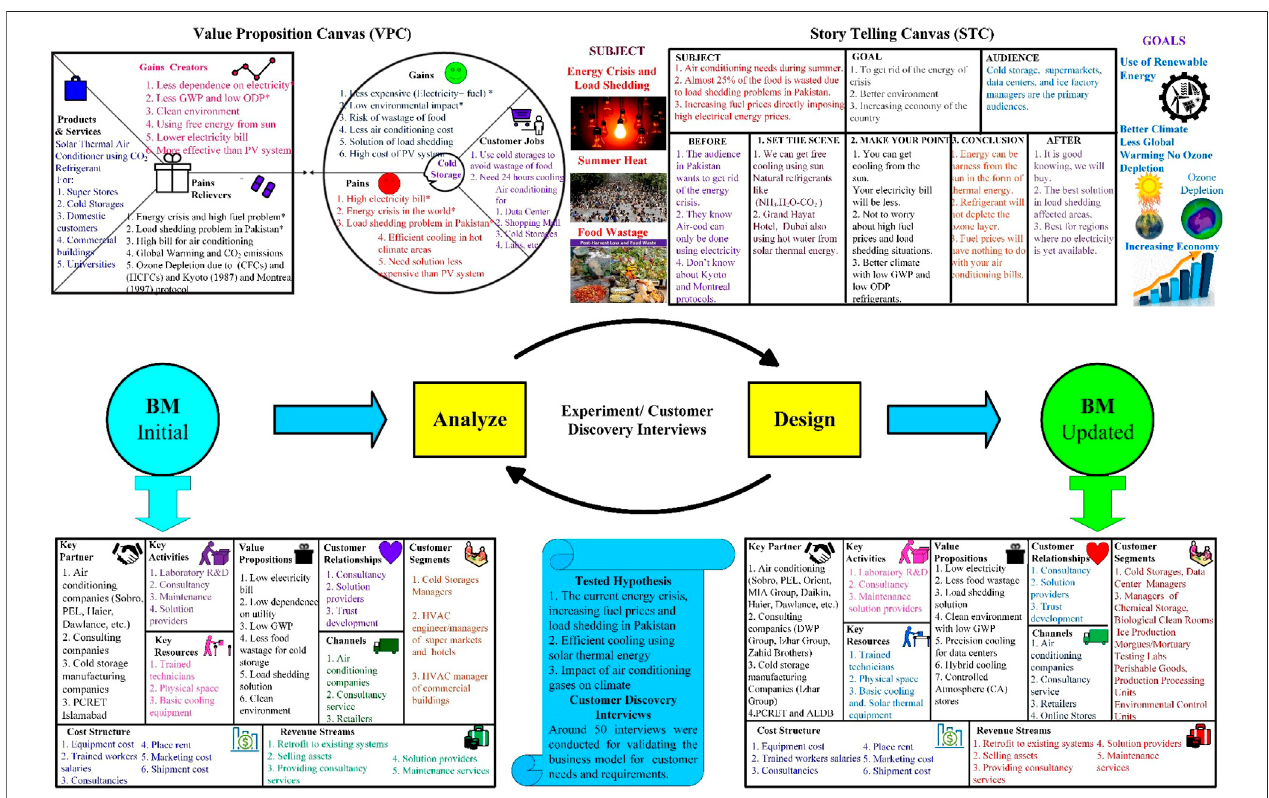
FIGURE 19 | Business model for solar thermal air conditioning in